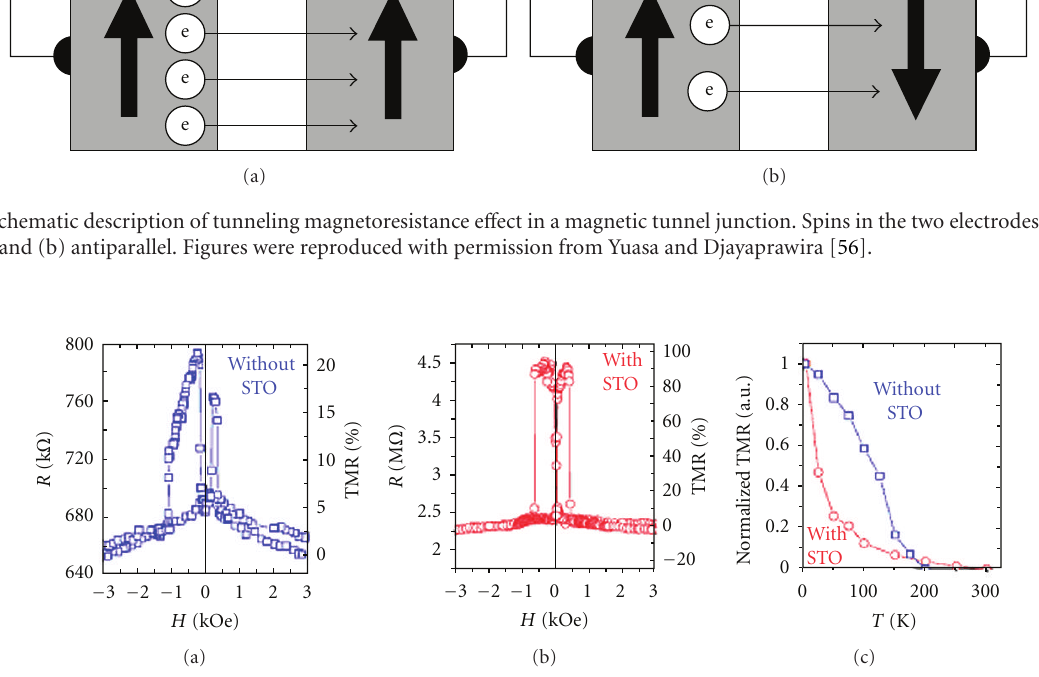
Figure 8: Resistance plotted as a function of magnetic field in magnetic tunnel junctions having Co and LSMO ferromagnetic electrodes and multiferroic BFO layer. The measurements were performed at 3 K and 10 mV: (a) BFO (5nm) single barrier, that is, without STO, (b) BFO (2nm)/STO (1.6nm) double barrier, that is, with STO, and (c) Evolution of the TMR with temperature for these two junctions. Figures were reproduced with permission from B´ea et al. [54].